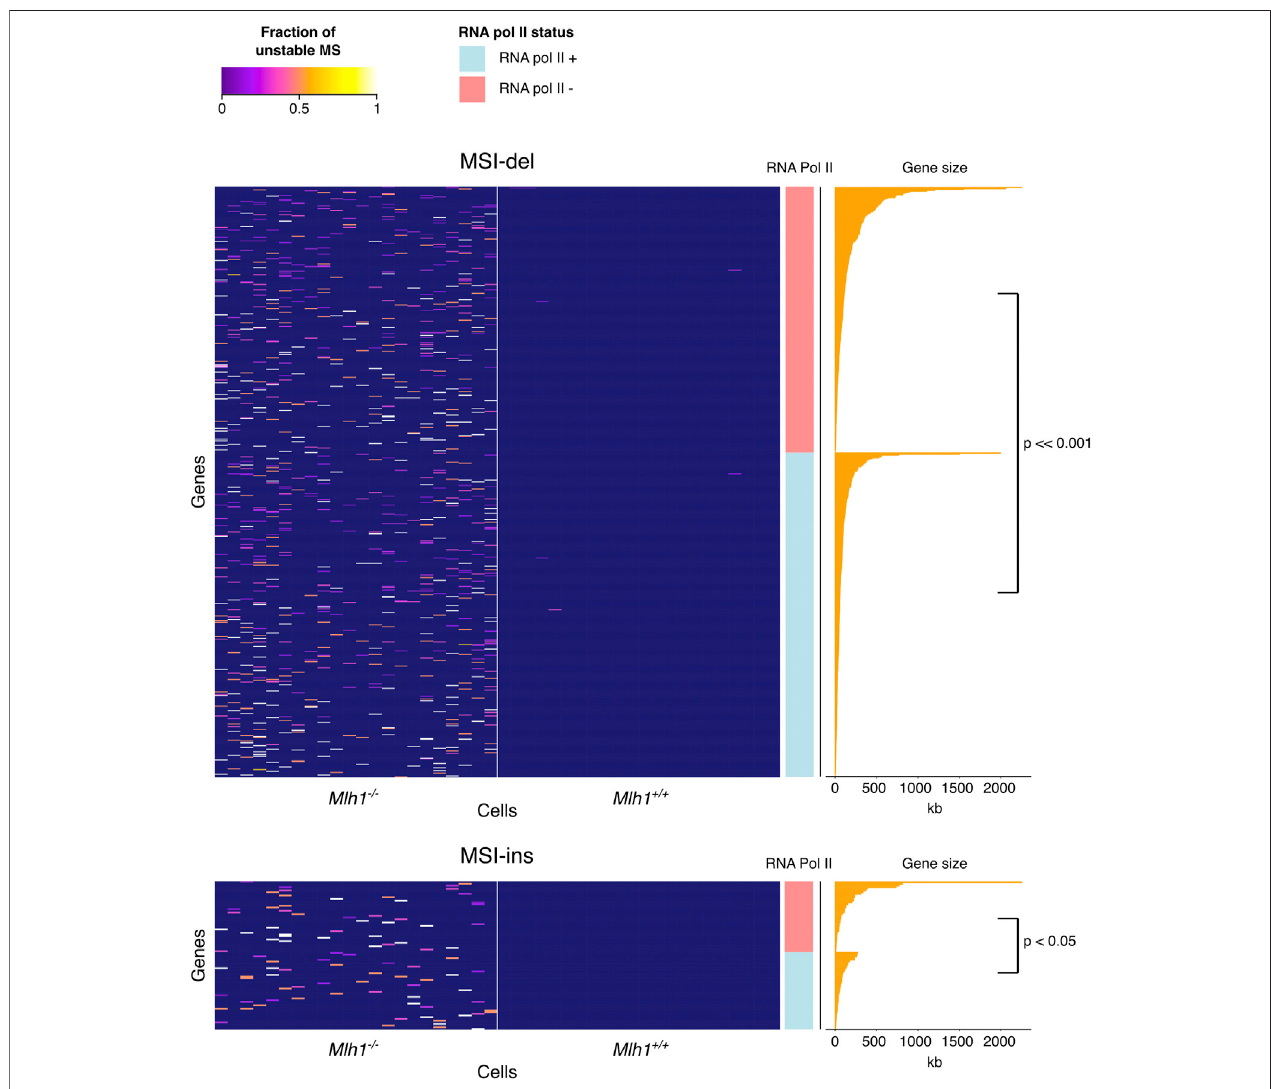
FIGURE 4 | MSI in the mouse exome is enriched in long or transcribed genes. Heatmap of MSI frequency in the MSI target genes. MSI target genes are devoid of mutationsinwildtype cellsand enriched witheithersilent longgenesorshorter,transcribed genes.Each column intheheatmaprepresentsonesingle-cellsampleofthe genotypes indicated at the bottom. Rows are sorted by RNA Pol II status and gene length. Deletions (upper panel), but not insertions (lower panel), cluster to the same high-MSI genes across different Mlh1 − / − cells.